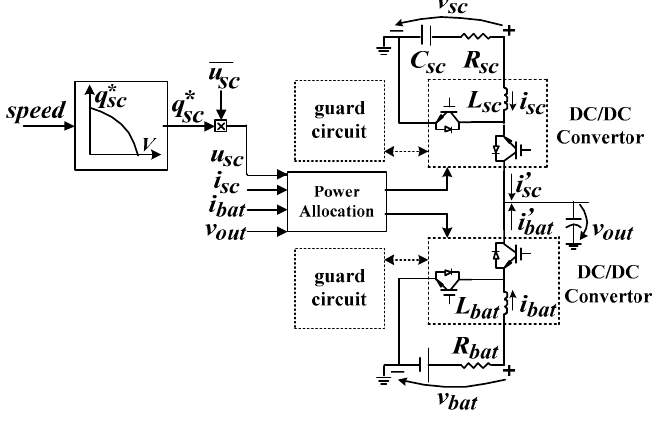
Figure 12. SOC control structure.